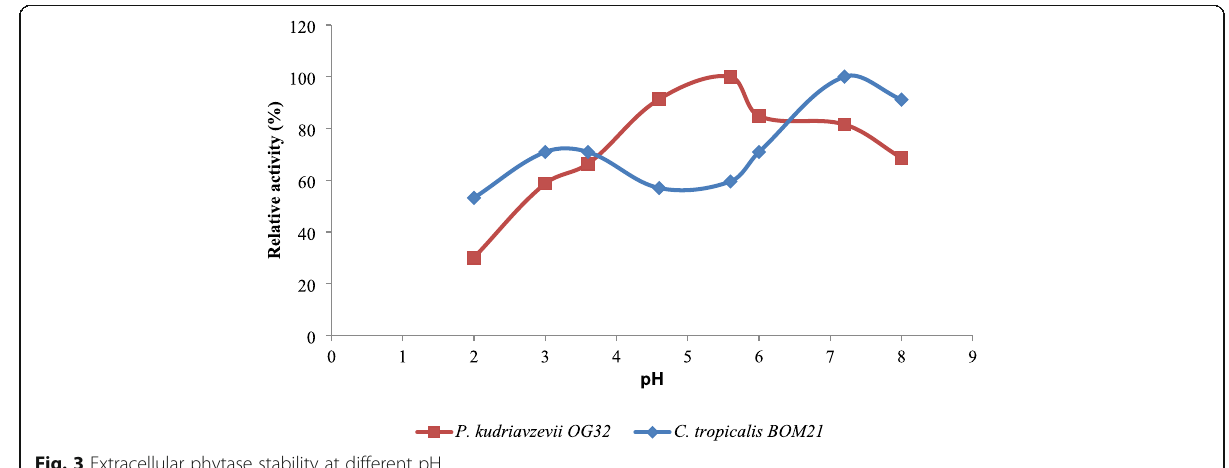
Fig. 3 Extracellular phytase stability at different